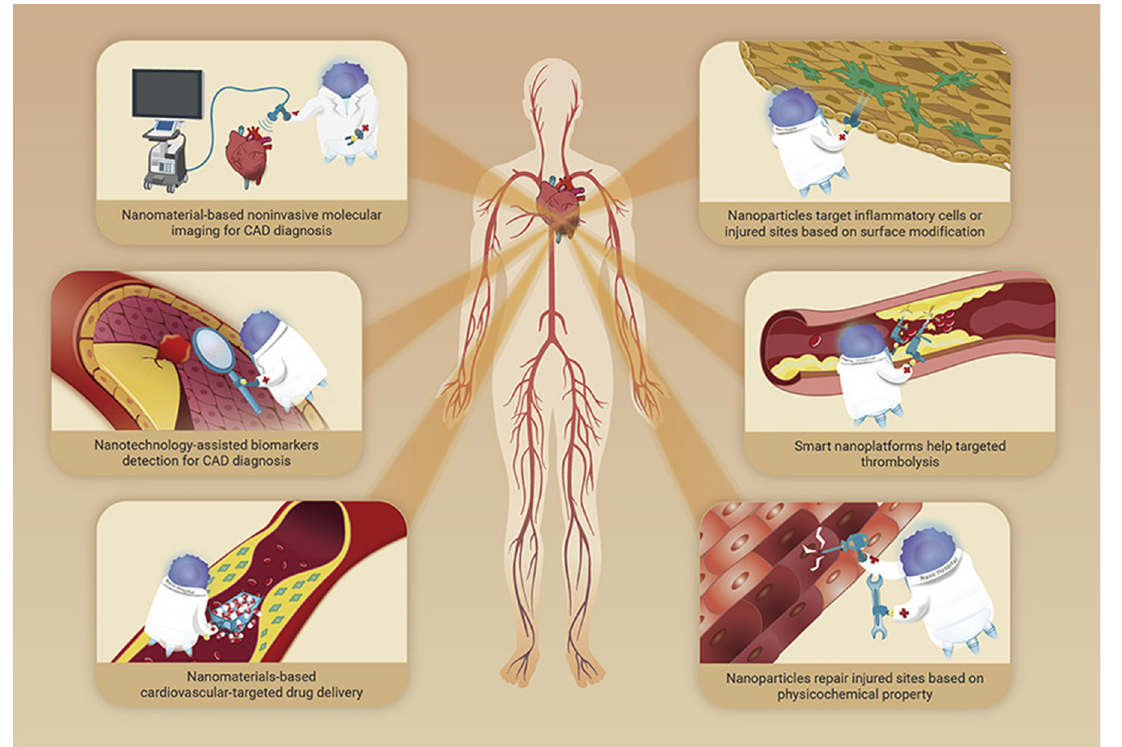
Figure 1. Feasible advances for the diagnosis and treatment of cardiovascular diseases (CVDs). Figure adapted with permission from Hu et al, 2022 [20].